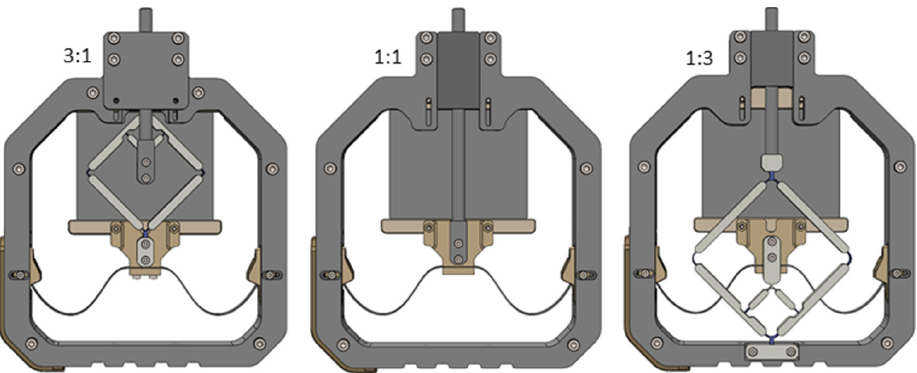
Figure 9. CAD comparison of the realized systems with the stroke-reducing transmission on the left , the system without transmission mechanism in the middle , and the stroke-magnifying transmission on the right